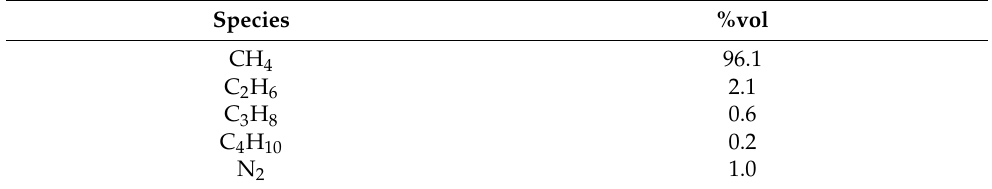
Table 1. Composition of natural